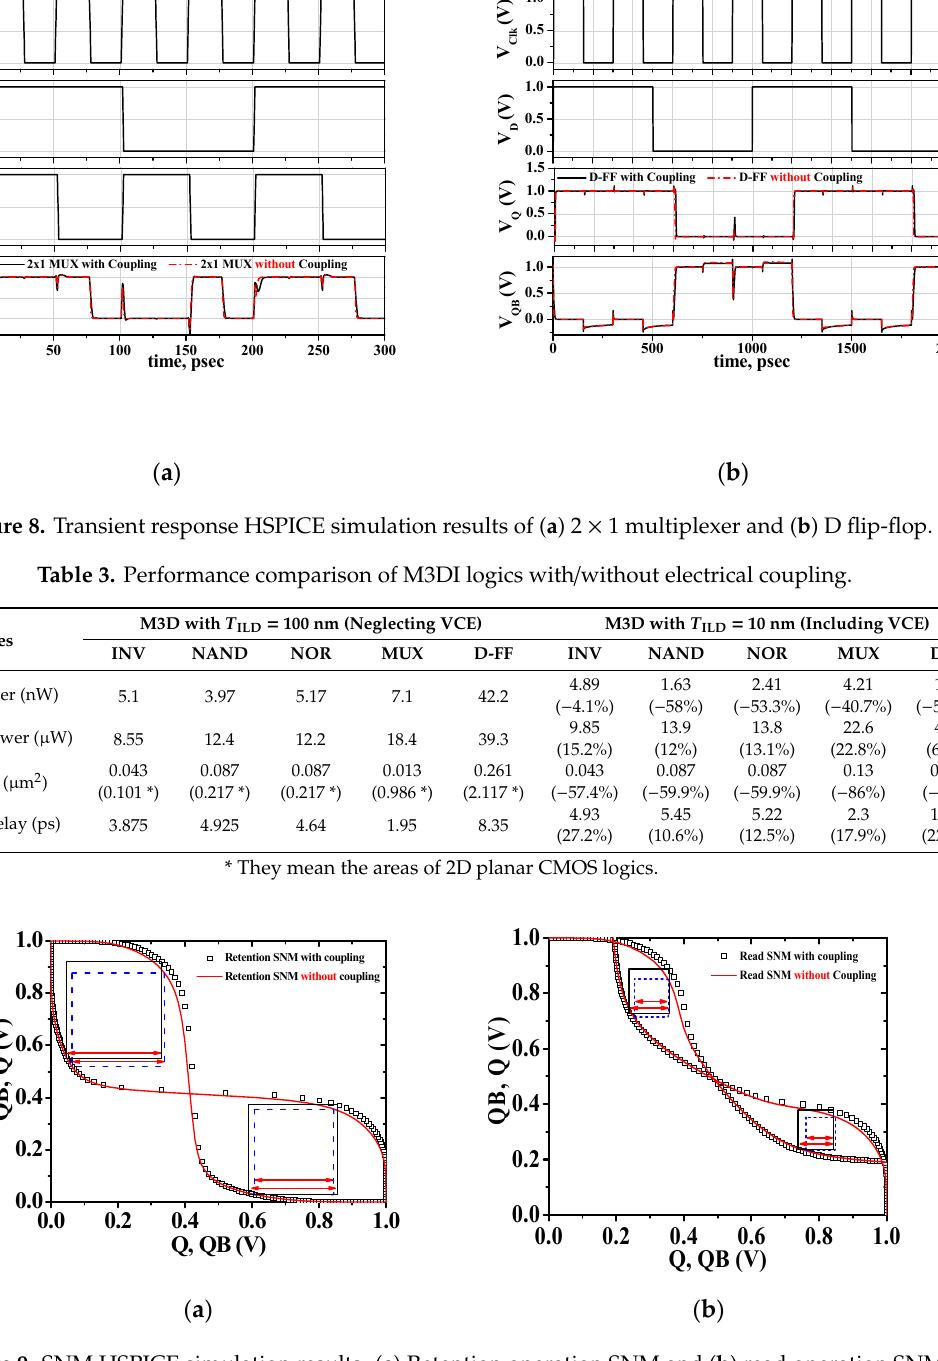
Figure 9. SNM HSPICE simulation results. ( a ) Retention operation SNM and ( b ) read operation SNM in 6T SRAM using M3DINV unit cell.